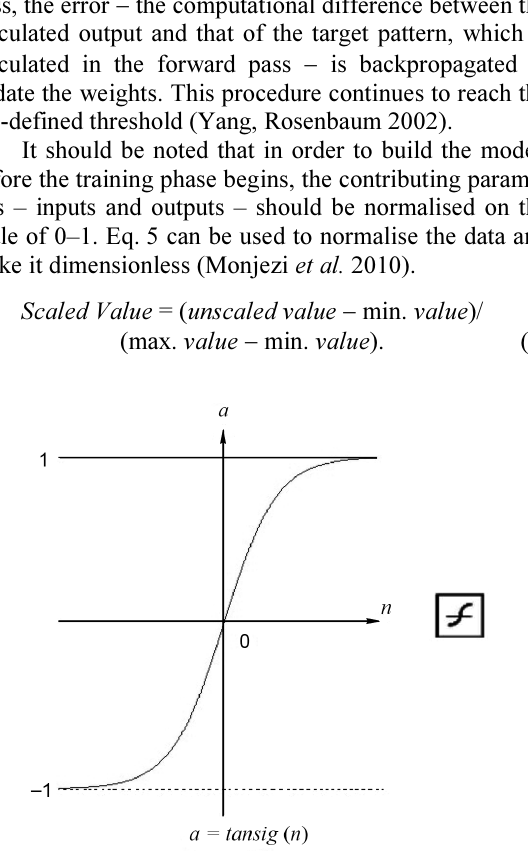
Fig. 2. Nonlinear TANSIG transfer function (Demuth et al. 1996)